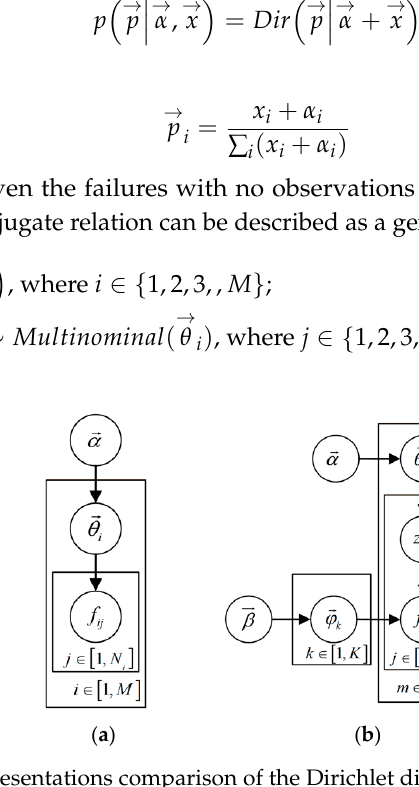
Figure 4. Graphical representations comparison of the Dirichlet distribution and LDA: ( a ) graphical representation of the Dirichlet distribution; ( b ) graphical representation of LDA.